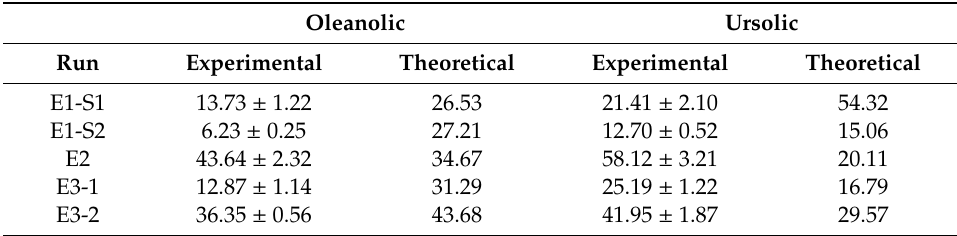
Table 4. Concentration (mg / g extract) of oleanolic and ursolic acid in the extracts obtained from the combined extraction of heather and marigold (50:50) by SFE. Theoretical values are expressed as the arithmetic mean of the experimental concentration in the extracts obtained from each individual plant. Oleanolic Ursolic Run Experimental Theoretical Experimental